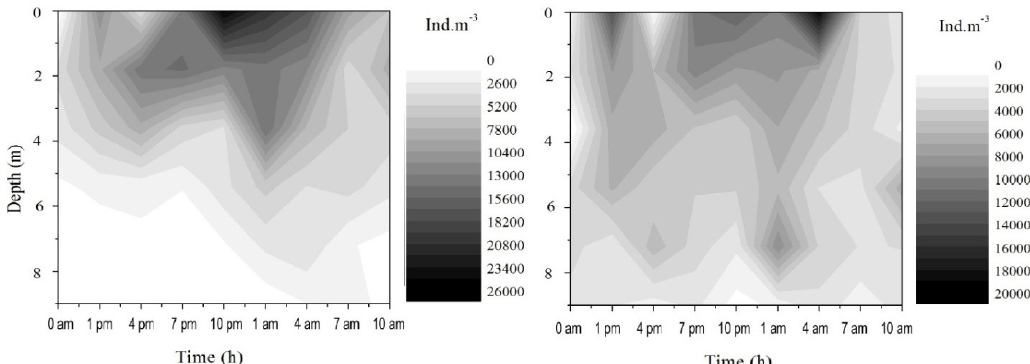
Figure 5. Vertical variation in population density of Diaphanosoma birgei and D. spnulosum (ind.m -3 ) during a single nictemeral cycle, at a study station in FR, from 10 am of January 15 to 10 am of January 16, 2014.